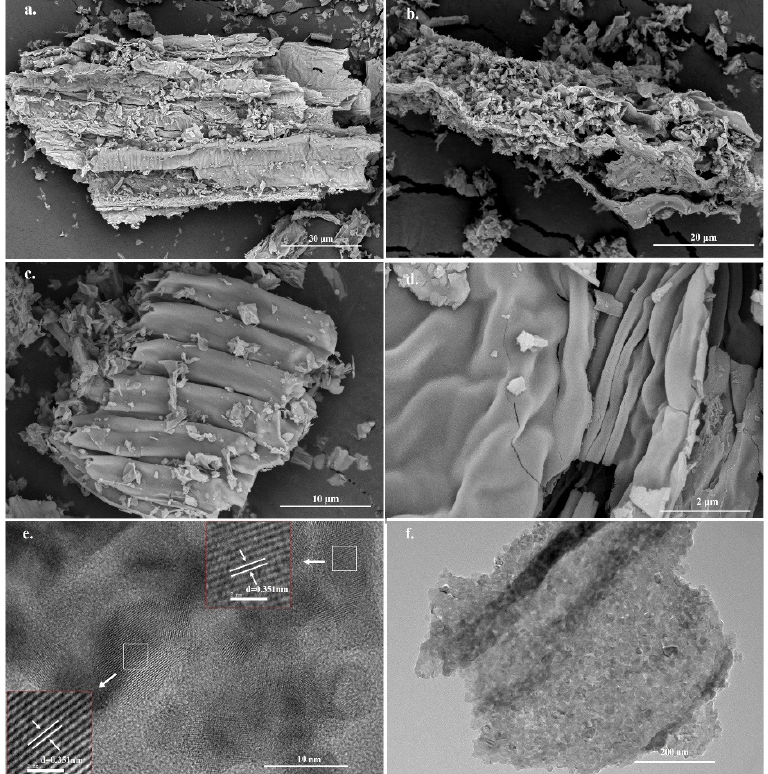
Figure 4. ( a – d ) SEM and ( e , f ) TEM images of Co-TiO 2